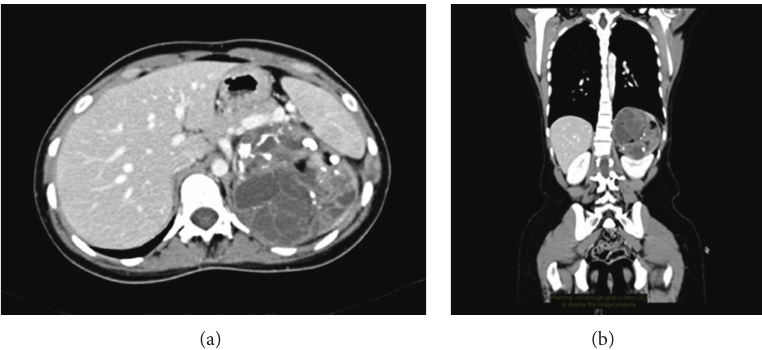
Figure 1: Abdominal contrast-enhanced computed tomography (CT) scan. (a) Cross-sectional (transverse) view: showing a large lesion in the region of left adrenal gland measuring 9.0×9.2×10.8 cm and demonstrating multiple cystic spaces with thin septations as well as multiple areas of fatty collections and coarse calcifications. (b) Coronal (frontal) view: showing displacement of left kidney